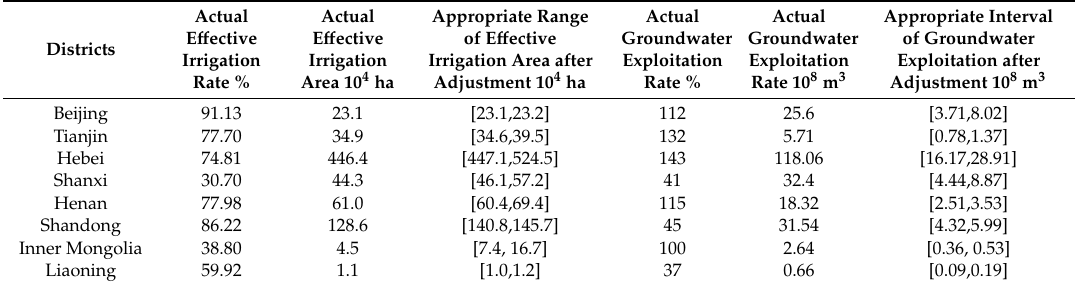
Table 6. Adjustment interval of the e ff ective irrigation area and the groundwater exploitation rate. Actual Actual E ff ective E ff ective Districts Irrigation Irrigation Rate % Area 10 4